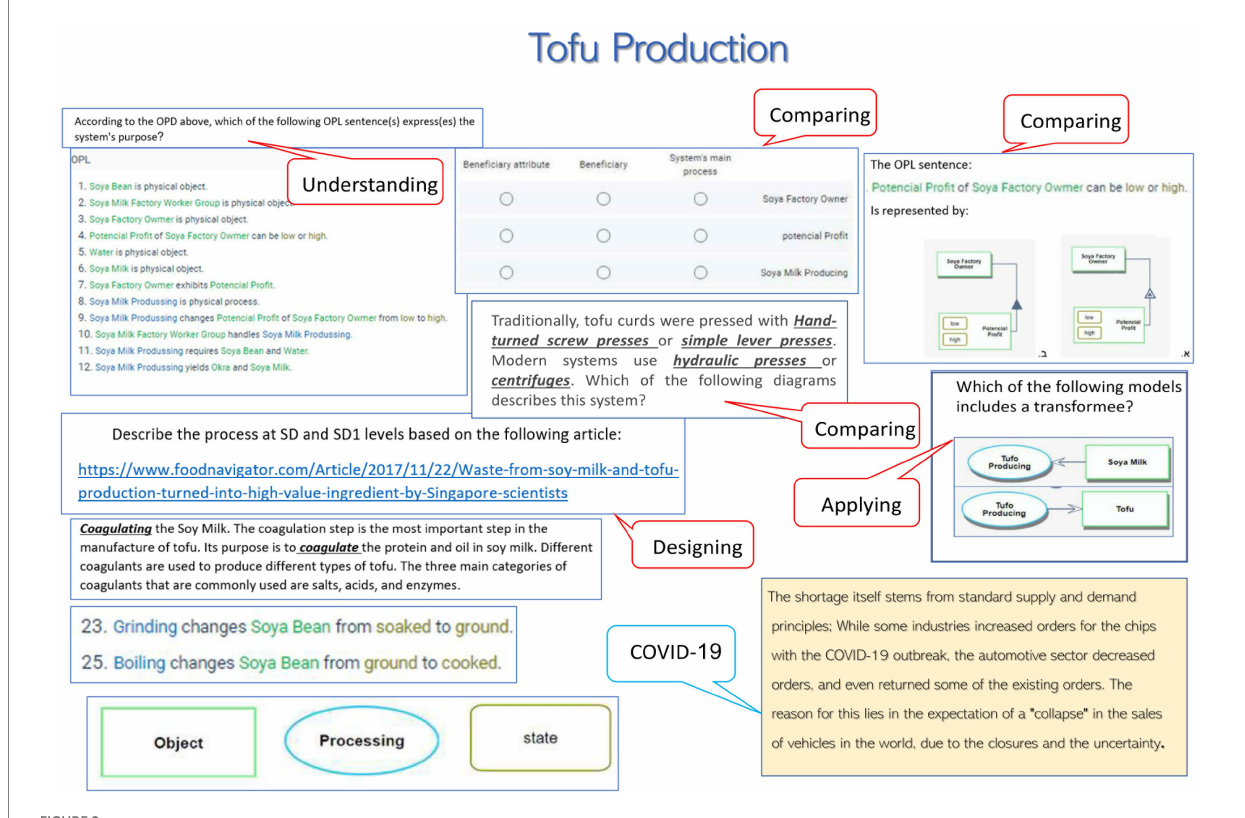
FIGURE 2 Selected segments from Anna’s tofu production